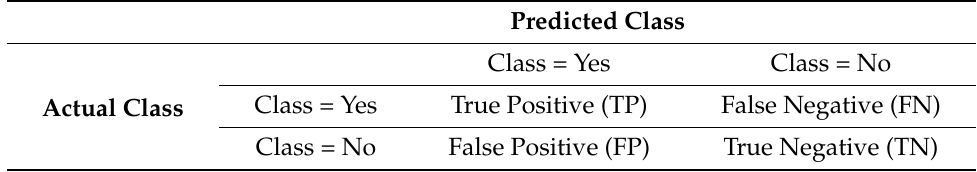
Table 3. The confusion